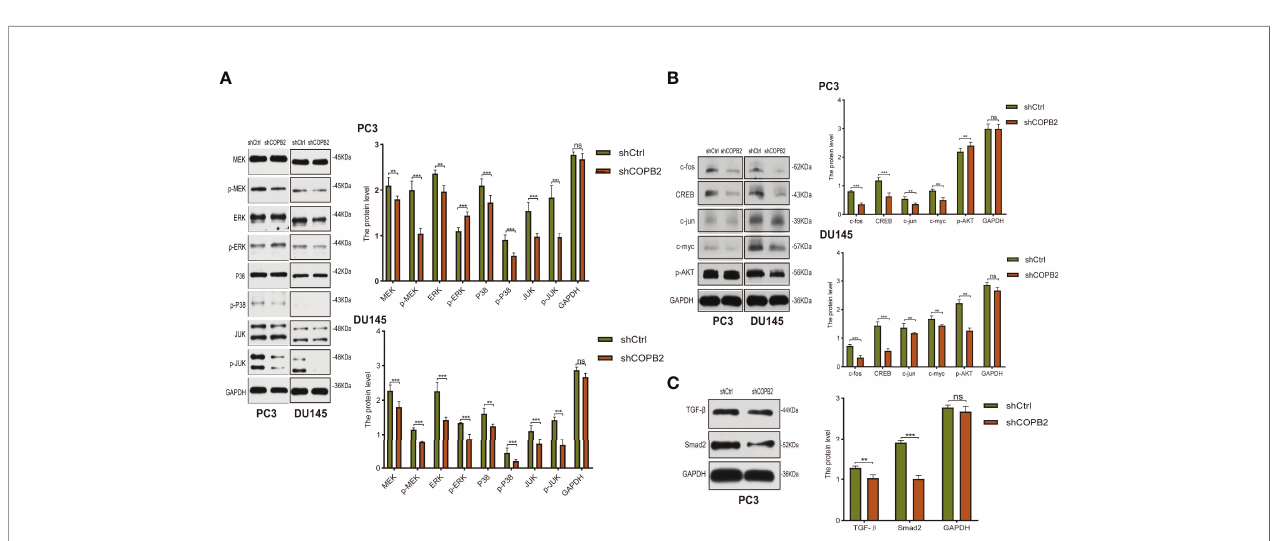
FIGURE 7 | MAPK and TGF- b signaling pathways mediated COPB2-induced proliferation of PCa cells. (A) Western blot analysis of MEK. p-MEK, ERK, p-ERK, P38, p-P38, JUK, p-JUK in shCOPB2 and shCtrl groups in PC-3 and DU-145 cell lines. (B) Western blot analysis of c-fos, CREB, c-jun, and c-myc in shCOPB2 and shCtrl groups in PC-3 and DU-145 cell lines. (C) Western blot analysis of TGF- b and Smad2 in shCOPB2 and shCtrl groups in PC-3 cell lines. ** P < 0.01, *** P < 0.001, ns, not signi fi cant.